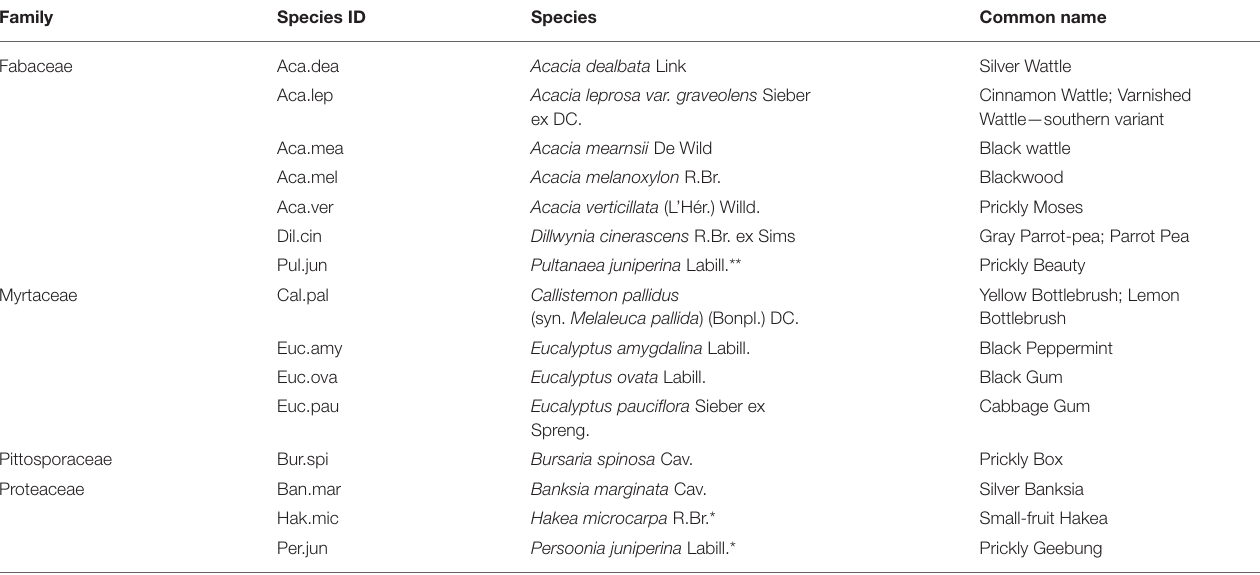
TABLE 1 | Midlands native flora shortlist, species arranged by family.